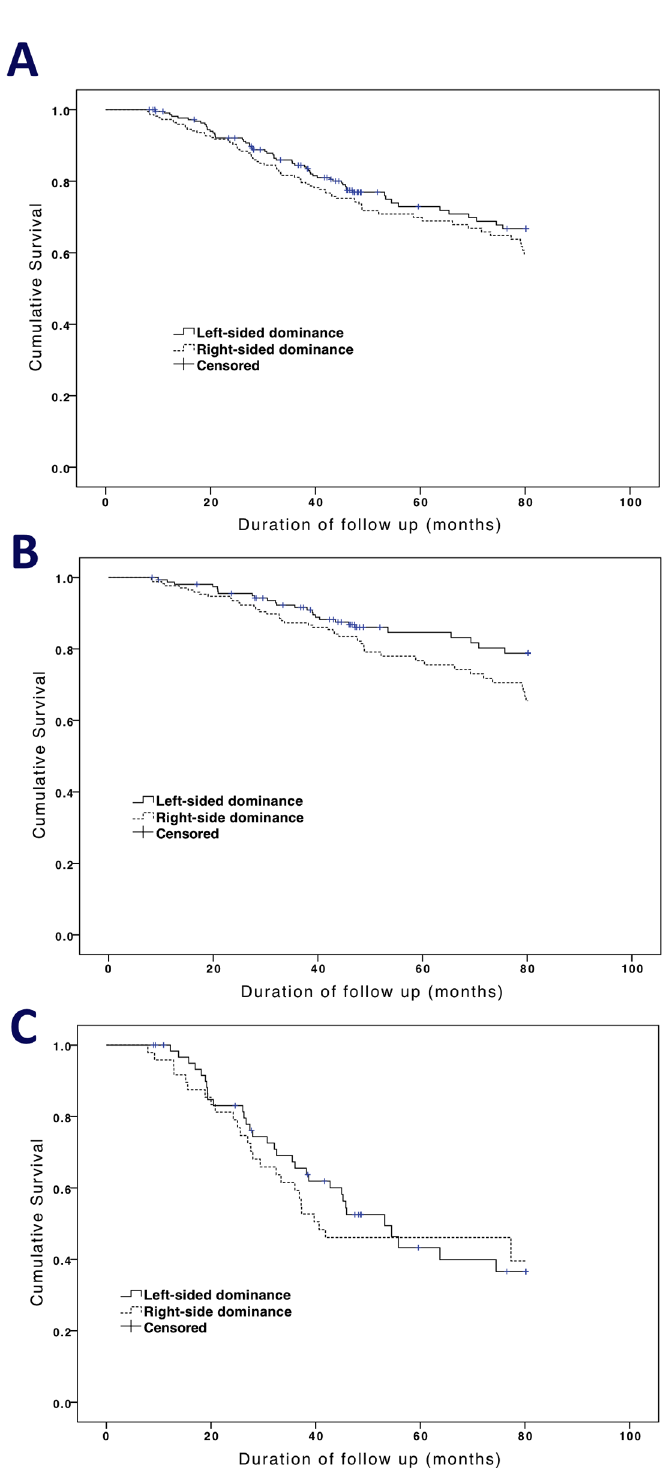
Fig 2. Probabilities of overall survival according to dominance side of ABI value. (A) in all patients with log-rank test: χ 2 = 1.32; P = 0.249; (B) in patients without PAOD with log-rank test: χ 2 = 3.47; P = 0.062; (C) in patients with PAOD with log-rank test: χ 2 = 0.20; P = 0.651.